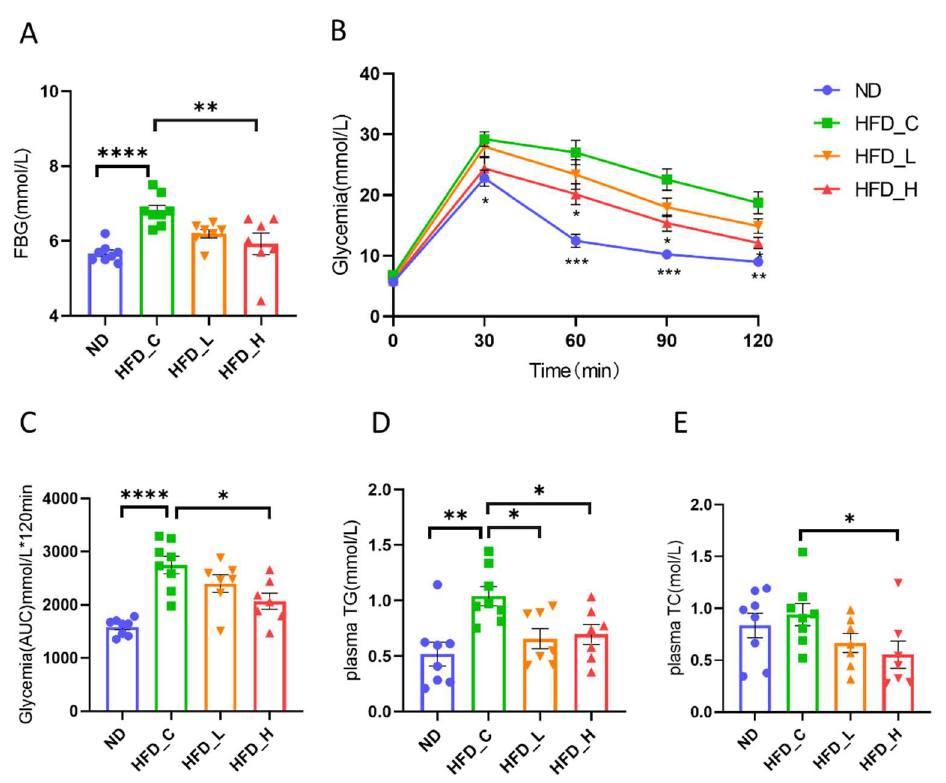
Figure 2. Effects of symbiotic supplementation on metabiotic parameters in rats. Comparative measurements of ( A ) fasting blood glucose (FBG), ( B ) intraperitoneal glucose tolerance test (IPGTT), ( C ) IPGTT area under the curve (AUC), ( D ) triglyceride (TG) and ( E ) total cholesterol (TC). Data are presented as mean ± SEM; * p < 0.05, ** p < 0.01 and **** p < 0.0001 compared with the HFD_C group.